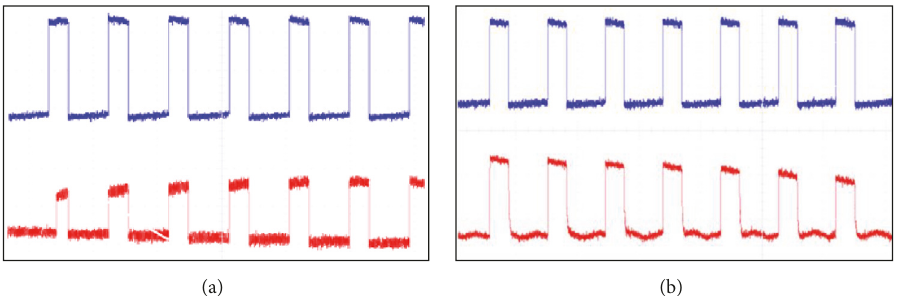
Figure 12: Current responses of emulator under pulse excitation. (a) Incremental type emulator; (b) decremental type emulator. The time scale is 25 ms/div and scale is 0.2 V/div for 𝑦